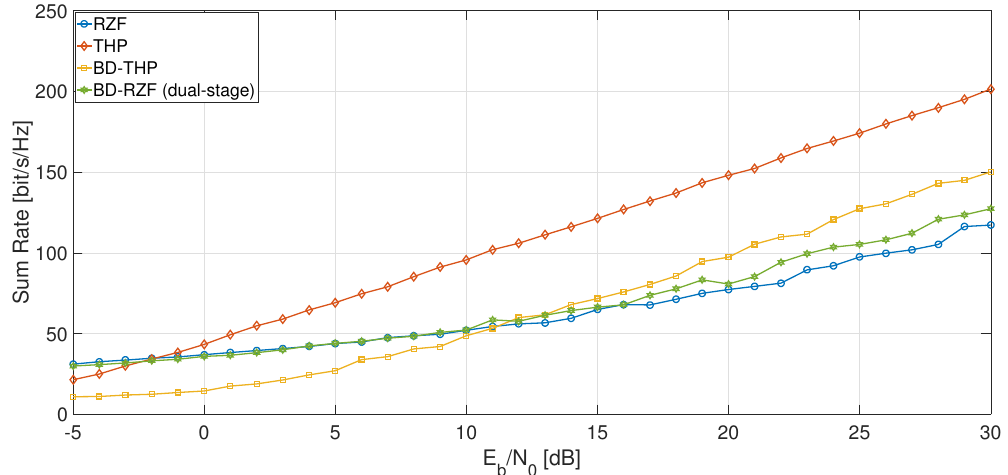
Figure 14. Sum rate vs. E b / N 0 for busy hour user distribution and random user